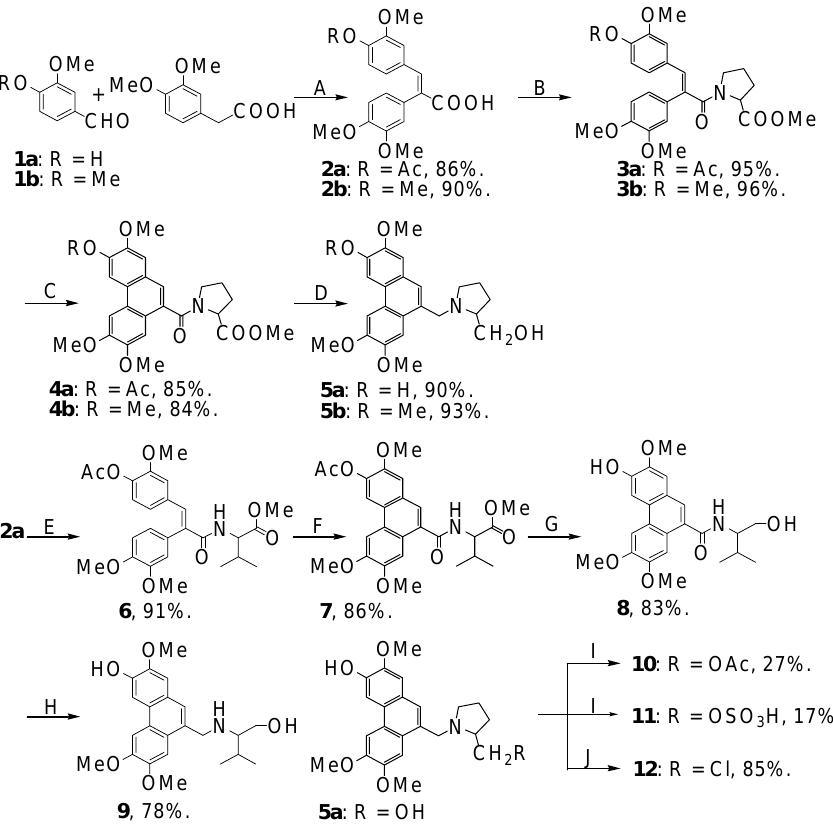
Scheme 1. The synthetic routes to